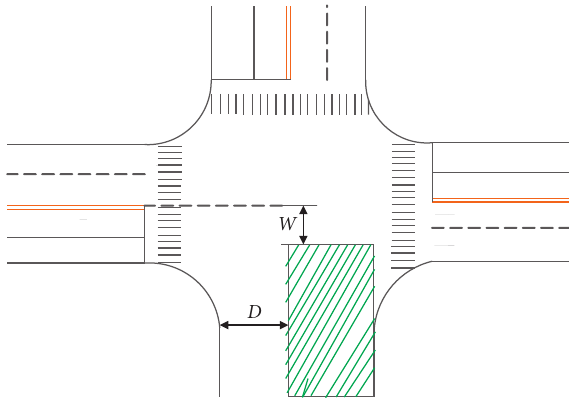
Figure 4: The intersection simulation